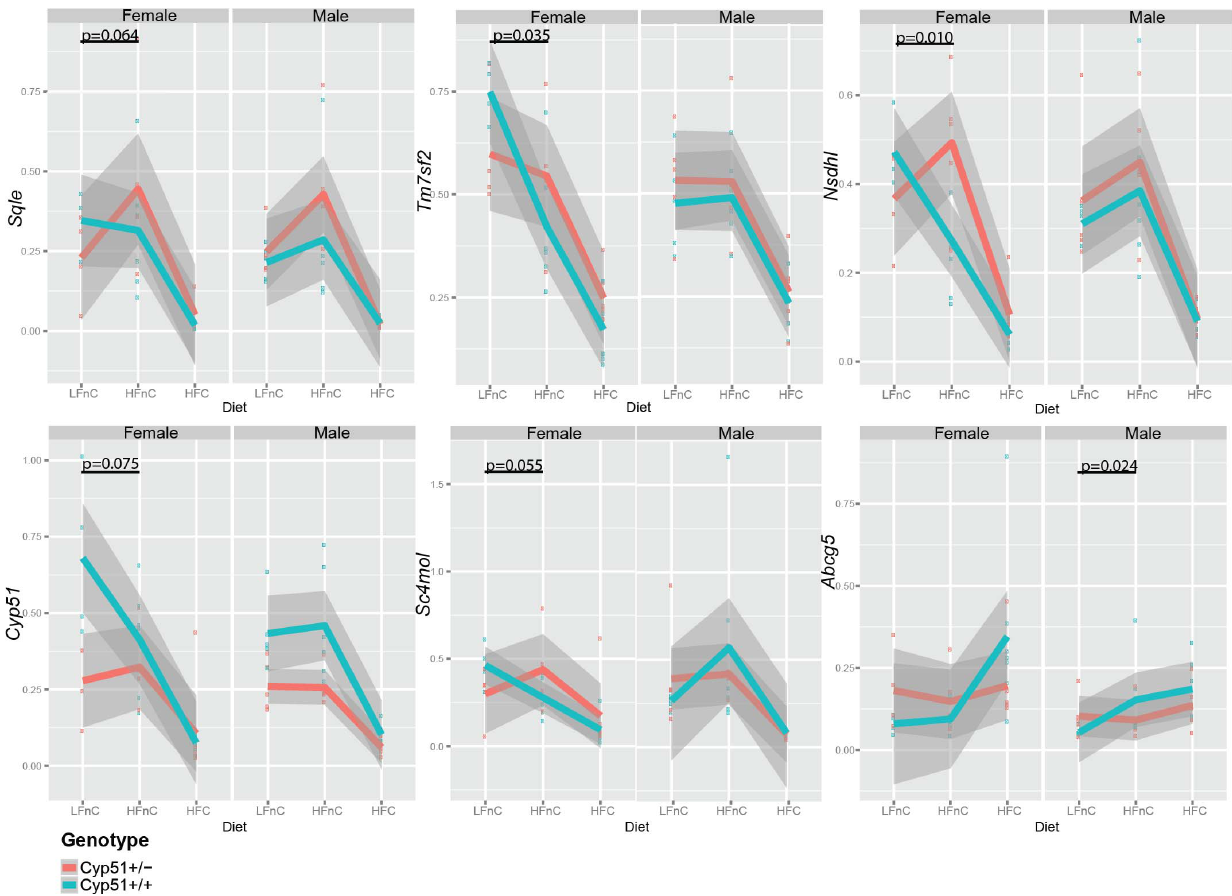
Figure 5. The diet-genotype interactions (effect of high fat feeding). Plots showing the change in expression levels in males and females, both Cyp51 + / 2 (red) and Cyp51 + / + (blue). Grey color indicates a linear smooth of 0.95 confidence intervals. The significant interactions between factors ( Cyp51 genotype and diet) that can be understood as the differences between slopes of lines are indicated by their p values.